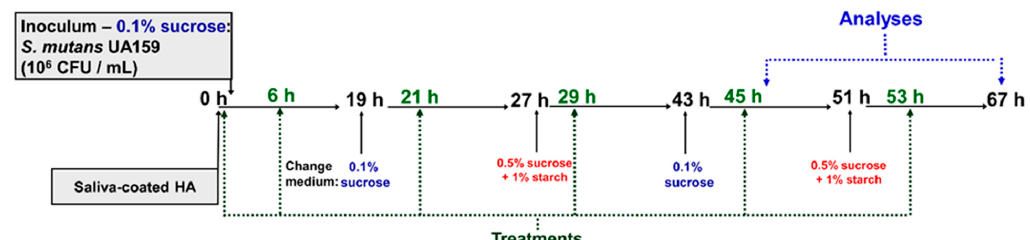
Figure 1. Experimental design for twice-daily topical treatments using a saliva-coated hydroxyapatite biofilm model. The treatments were performed at 0 (pellicle, before starting incubation with S. mutans ), 6, 21, 29, 45, and 53 h of biofilm development. The biofilms were analyzed at 46 and 67 h. The pH of the spent medium was evaluated at 19, 27, 43, 46, 51, and 67